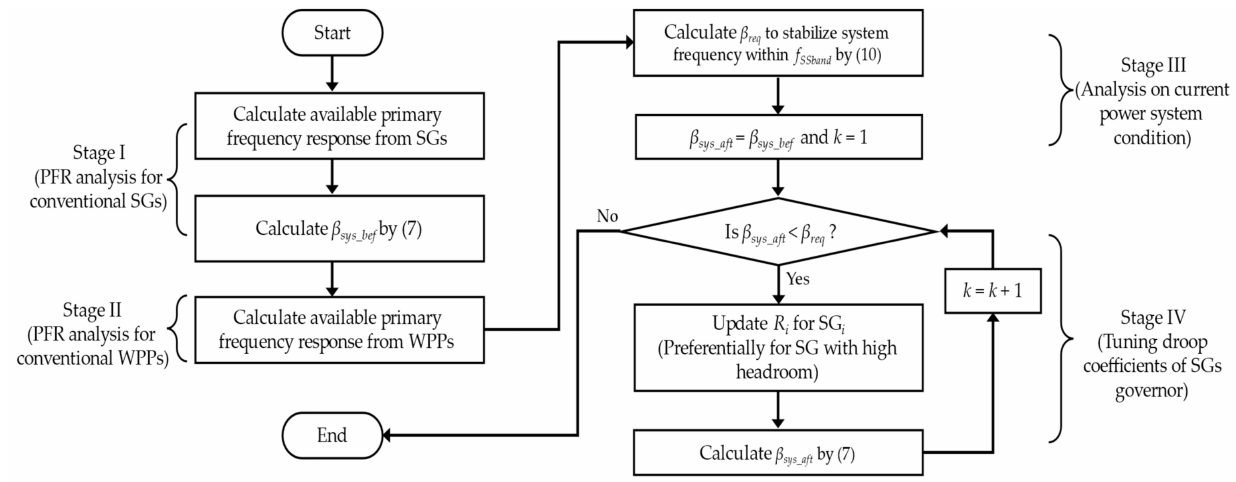
Figure 4. Overall procedure to determine the droop